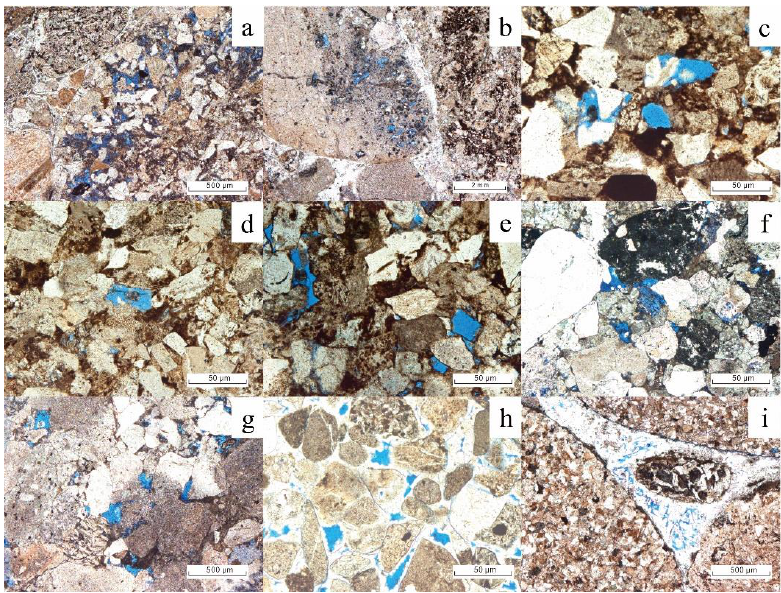
Figure 6. Cast thin sections of dissolution in study area. ( a ) Well YB4, 3913.77 m, Lower Wuerhe formation, intragranular dissolved pore; ( b ) Well YB4, 3915.31 m, Lower Wuerhe formation, intra- granular dissolved pore; ( c ) Well YT1, 4538.73 m, Baikouquan formation, mold pore; ( d ) Well YT1, 4538.05 m, Baikouquan formation, mold pore; ( e ) Well YT1, 4533.83 m, mold pore; ( f ) Well YB4, 3692.21 m, Baikouquan formation, remaining intergranular pores; ( g ) Well YB4, 3693.04 m, remaining intragranular pores; ( h ) Well YB1, 4070.9 m, Lower Wuerhe formation, laumontite-dissolved pore; ( i ) well YB4, 3869.37 m, Lower Wuerhe formation, laumontite-dissolved pore.